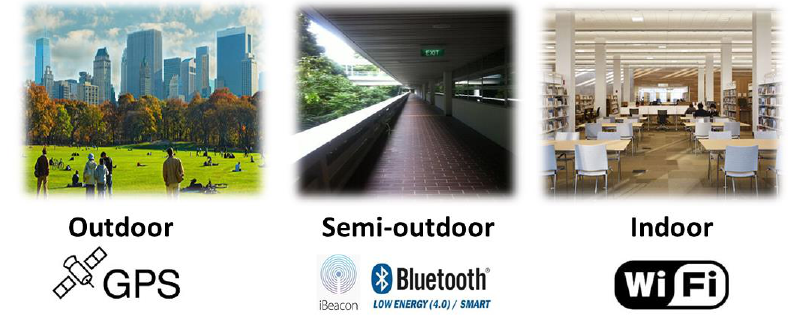
Figure 2. Representative scenes and corresponding localization technologies of three different